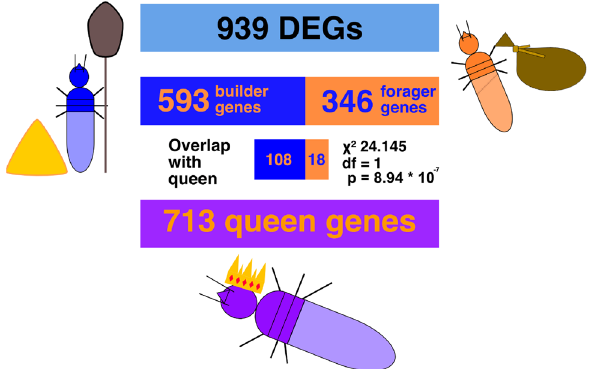
Figure 1. Graphical representation of overlapping genes. We compared the DEGs between builders and foragers (939) with genes that were upregulated in queens compared to the other castes (713). The data for the latter were derived from our previous study 43 . Of the DEGs, those upregulated in builders were more commonly shared with queens (108 of 593) than those upregulated in foragers (18 of 346) ( χ 2 = 24.15, df = 1, p = 8.94